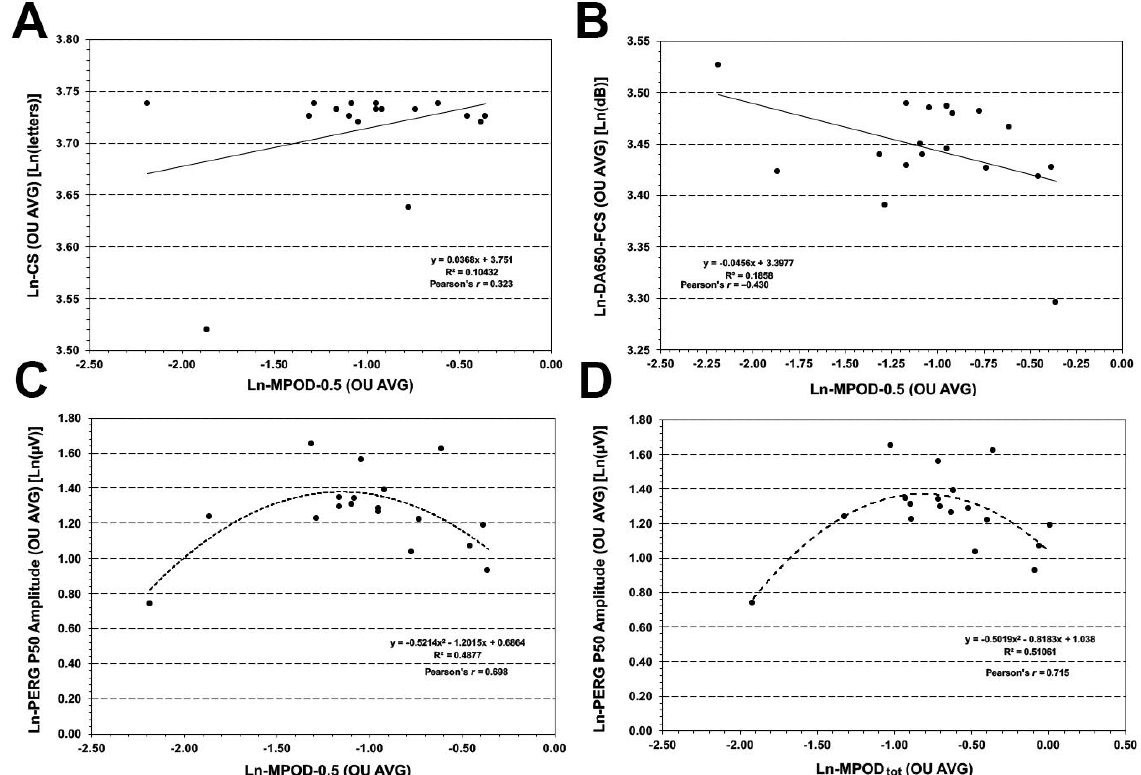
Figure 1. Baseline correlation analyses between macular pigment optical density (MPOD) and measures of macular function. The direct correlation between natural log (Ln) contrast sensitivity (CS) based on number of letters read at the Pelli-Robson test and Ln-MPOD measured at 0.5 deg of eccentricity (MPOD-0.5) is illustrated in ( A ). The inverse correlation between natural log (Ln) DA650-FCS and Ln-MPOD-0.5 is presented in ( B ). The curvilinear, ∩-shaped correlation between Ln-PERG P50 amplitude and Ln-MPOD-0.5 is shown in ( C ). The same correlation pattern was seen also for Ln-PERG P50 amplitude and Ln-MPOD tot and is illustrated in ( D ).